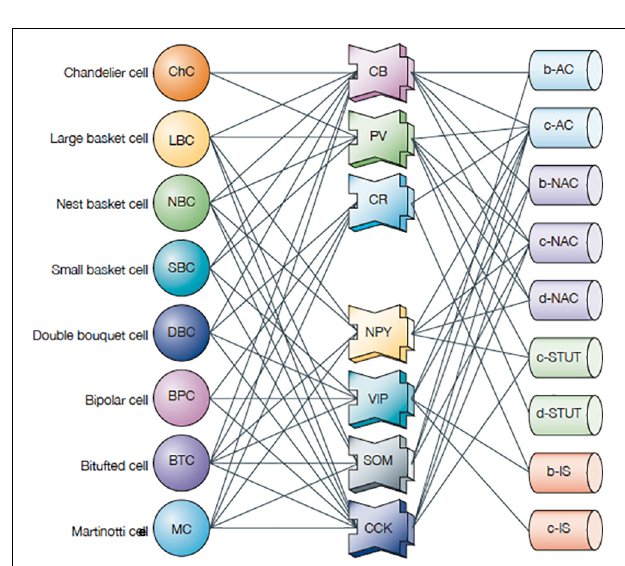
FIGURE 8 | Interneurons (left column) in the neocortex: correlation of expression of calcium-binding proteins (CBPs: middle column: CB, calbindin; PV, parvalbumin; CR, calretinin NPY) and neuropeptides (NPY, neuropeptide Y; VIP, vasoactive intestinal peptide; SOM, somatostatin; CCK, cholecystokinin) with different morphological and electrophysiological classes (right column: AC, accommodating; b, burst; c, classic burst; d, delay burst; iS, irregular spiking; NAC, non-accommodating; STUT, stuttering) [Adapted from Markram et al.